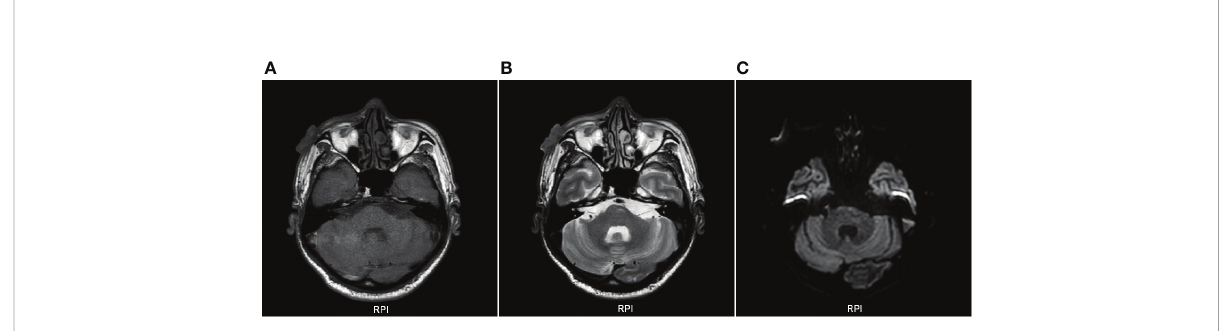
FIGURE 2 Plain scan of super fi cial soft tissue on MRI. (A) , T1WI showing slightly hyperintensity; (B) , T2WI showing slightly hyperintensity; (C) , DWI and brain parenchyma were isointense.